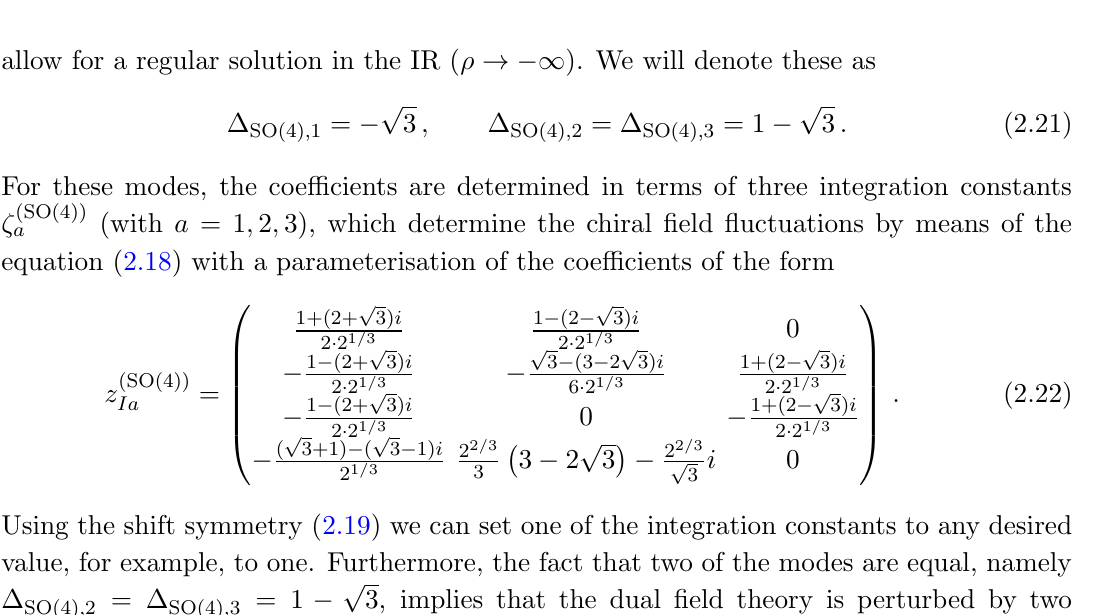
Table 3 . Number of relevant, irrelevant and marginal operators dual to the scalar modes in the AdS 4